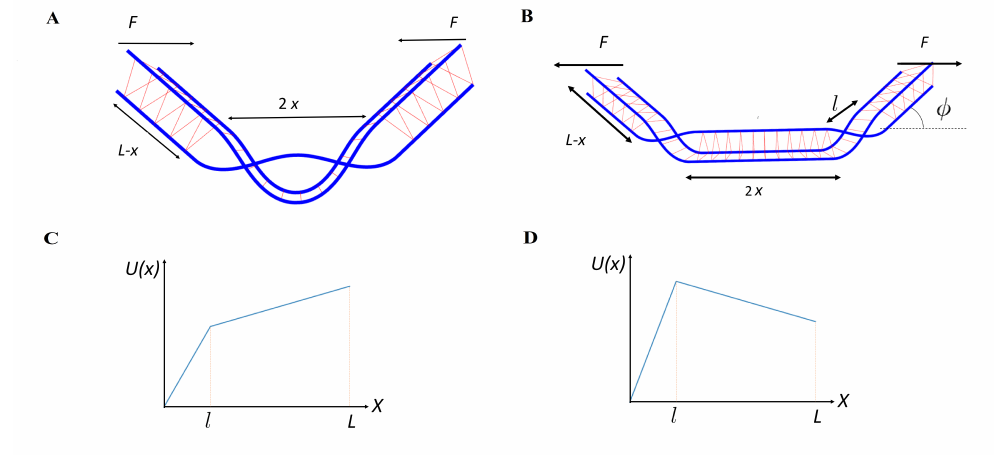
Figure 1. Schematic illustration: ( A ) A pair of braids produced under compression force F on a semiflexible filament bundle of length 2 L (and comprised of three filaments), but not separated. 2 x is the size of the defected region. The filaments are shown in blue, while the cross links are shown in red. ( B ) A pair of braids is now separated under applied tension. The braids produce a kink with angle φ and 2 x is the distance between the braids (including their own size—the total excess length stored within the braid). In the lower figures, we show the piece-wise linear potential U ( x ) under compression ( C ) and under extension ( D ) . The left part of the potential x < l corresponds to the production of defects, while the right x > l controls the separation of the